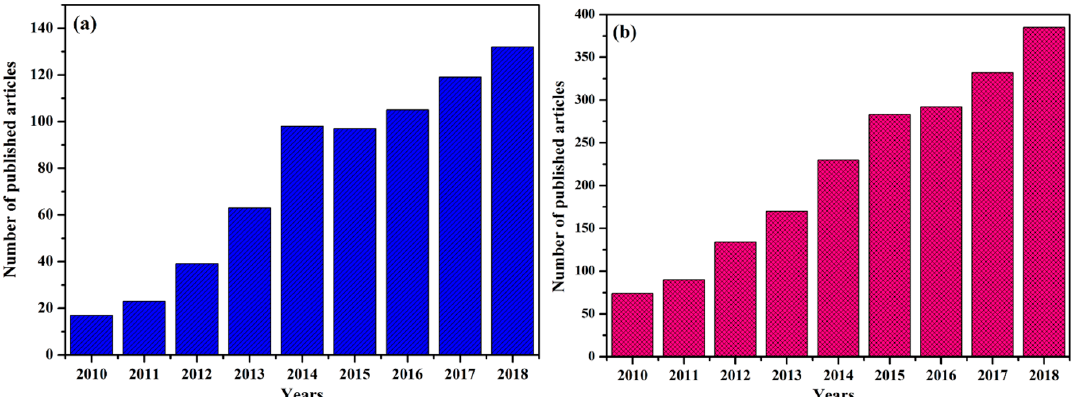
Figure 4. Trends in the number of published articles on ( a ) layer-by-layer approach for supercapacitors, ( b ) conducting polymer for supercapacitors from 2010 to 2019 using the keyword “layer-by-layer, conducting polymer and supercapacitor”. (Data is collected from Scopus on 18 April 2019).